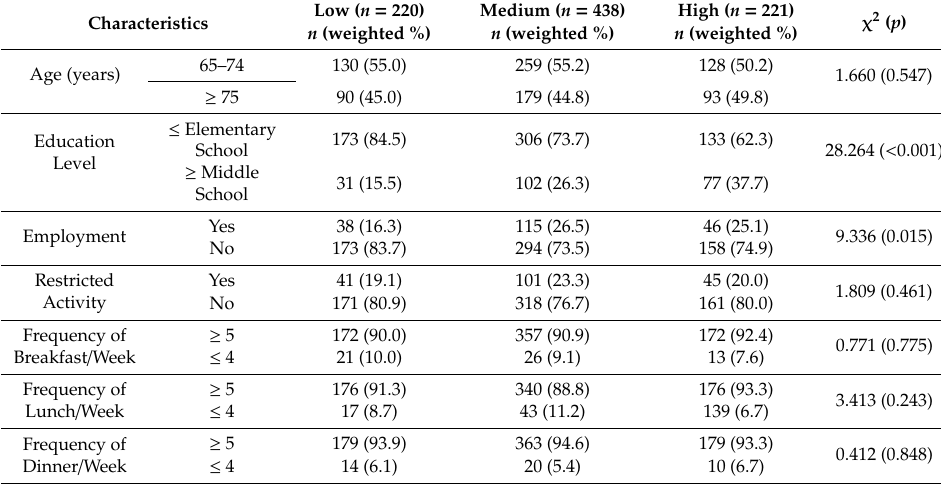
Table 1. Demographic Characteristics by Economic Group